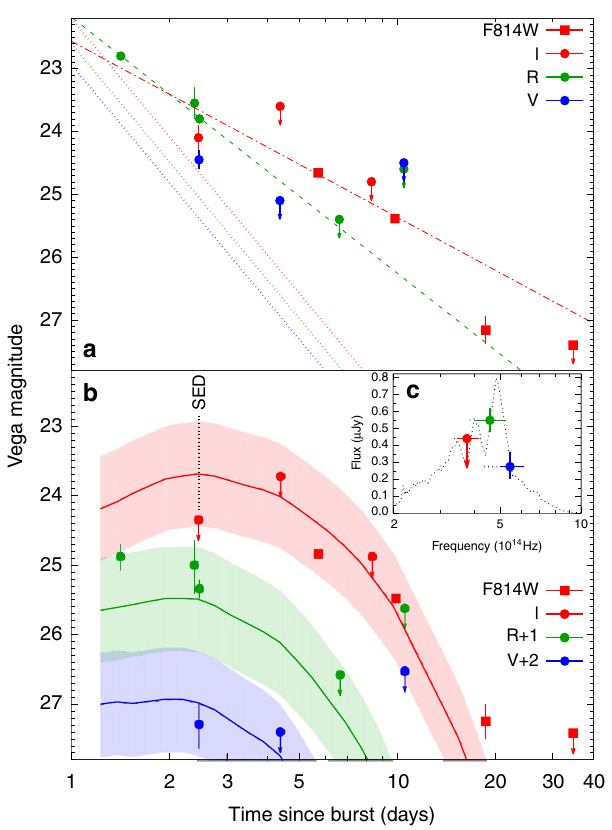
Figure 1 | The optical observations of sGRB 050709 and the macronova component. ( a ) The fits to the R -band emission (green dashed line) and to the I -band observations from the VLT I -band data as well as the first two HST F814W-band data points (red dash-dotted line) yield the declines of t (cid:3) 1.63 ± 0.16 and t (cid:3) 1.12 ± 0.09 , respectively. The dotted lines represent the ‘suggested’ afterglow emission lightcurves of the GRB outflow after the jet break (that is, t (cid:3) 2.5 for the energy distribution index of the shock-accelerated electrons p B 2.5). ( b ) Shown are the residuals of the